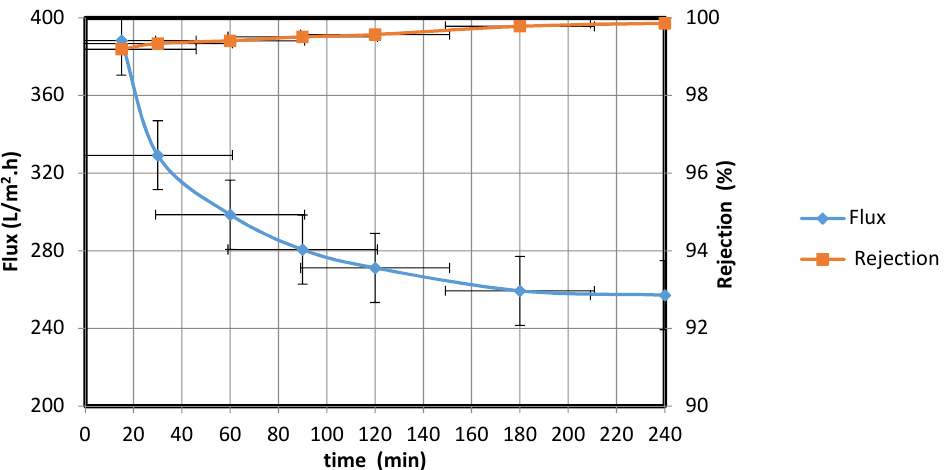
Figure 12. Water/synthetic oil flux rate through membrane and percentage rejection by fabricated membrane at different times.